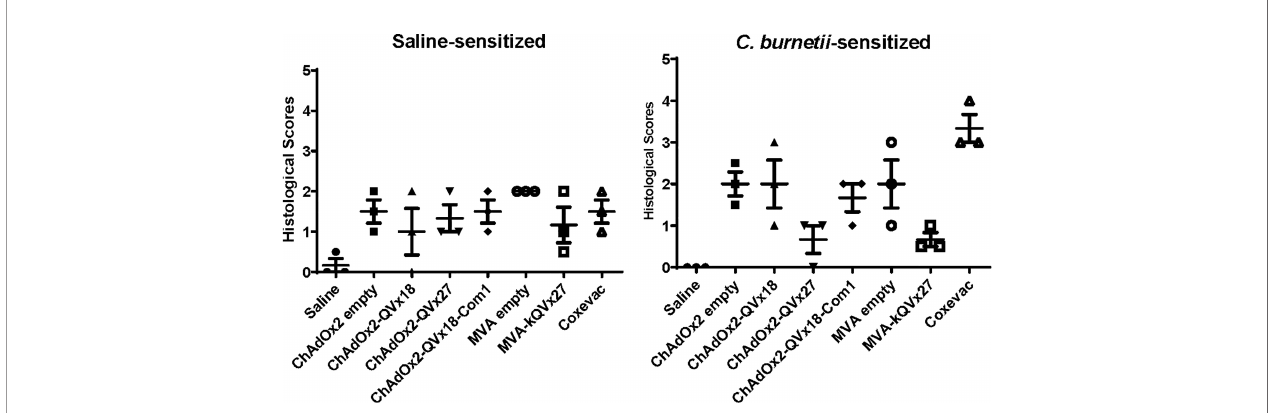
FIGURE 5 | Histological assessment of reactions to vaccine challenge in guinea pigs. Female guinea pigs (n=3/group) were sensitized by intranasal inoculation with 10 6 GE of C. burnetii Nine Mile strain or saline, as described previously (41). Intradermal vaccine challenges (summarized in Table 3 ) are indicated on the X axes. Histological lesions of skin biopsies were scored on a graded scale (41). Data are presented as the mean score from two skin sections per inoculation site for each animal; bars indicate group mean and standard deviation.